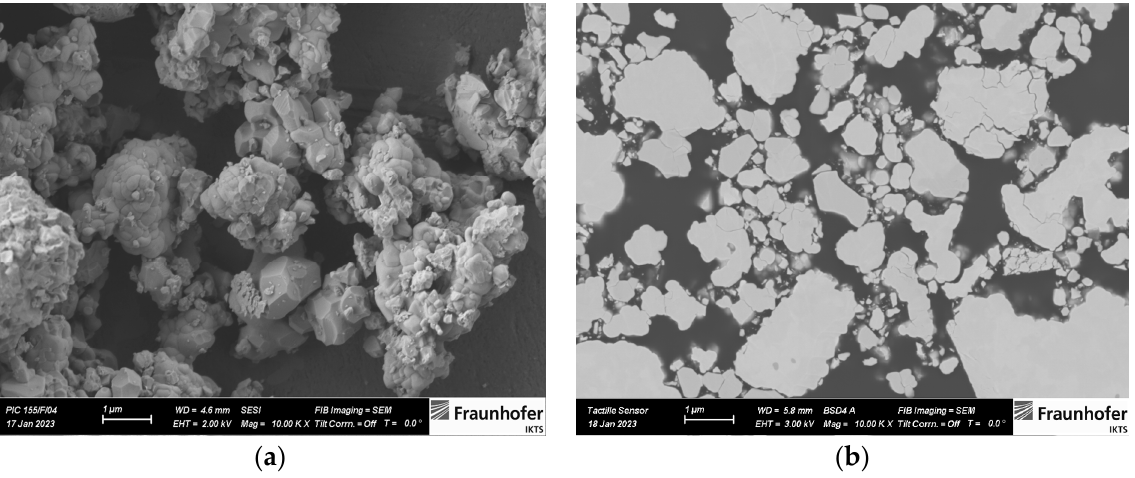
Figure 1. Field emission scanning electron microscopy images: ( a ) PZT particles; ( b ) 0 ‐ 3 PZT–PVB Figure 1. Fieldemissionscanningelectronmicroscopyimages: ( a )PZTparticles; ( b composite.